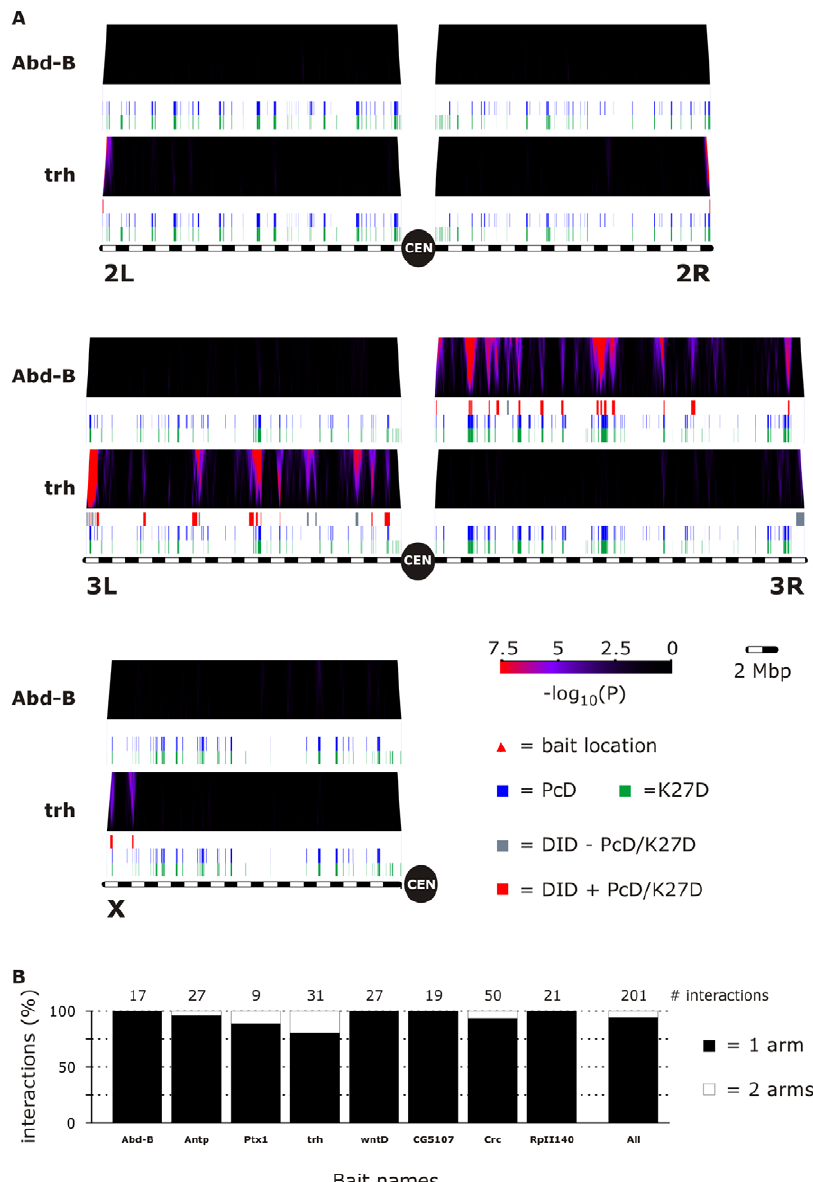
Figure 6. Long-range interactions predominantly occur within a single chromosome arm. (A) Domainograms show two illustrative examples of genome-wide interaction maps using either Abd-B (top) or trh (bottom) as bait. Plots are described in Figure 1B and Figure 2. Note, the small repeat-rich chromosome 4 is not shown. (B) Bar plots depict fraction of interactions within bait containing chromosome arm (black) and interactions with other chromosome arms (white). Bait names are indicated (x-axis) as well as absolute number of interactions (top). Across eight data sets we identified 201 interactions (all), of which , 95% are limited to a single chromosome arm, which also contains the bait sequence, and only 5% occurs between sequences on two chromosome detect significant changes relative to wild type gene expression,